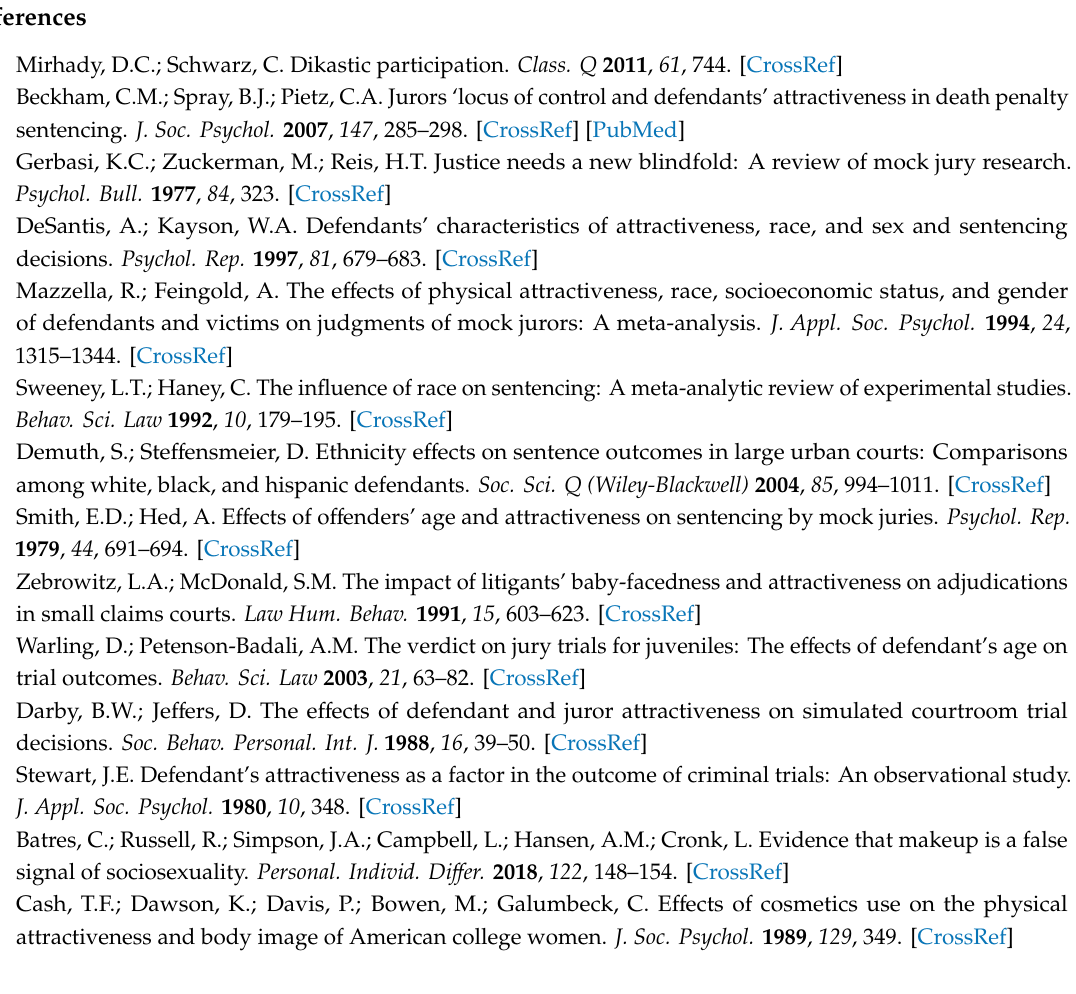
Figure A5. Trial vignette used in Study 2.